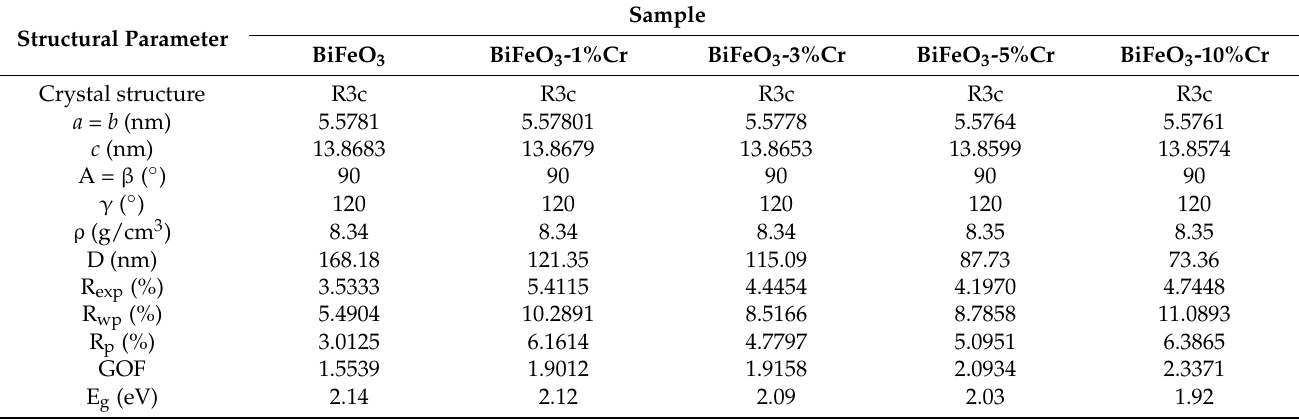
Table 2. Structural parameters of pure and Cr-doped BiFeO 3